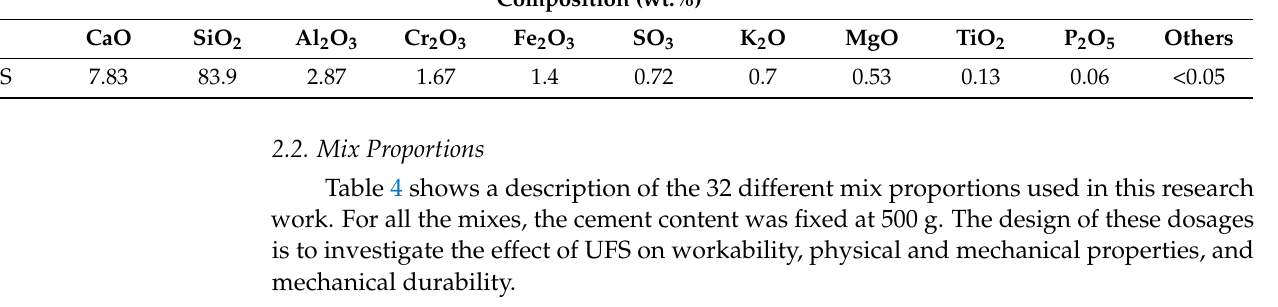
Table 4. Mortar mix proportion